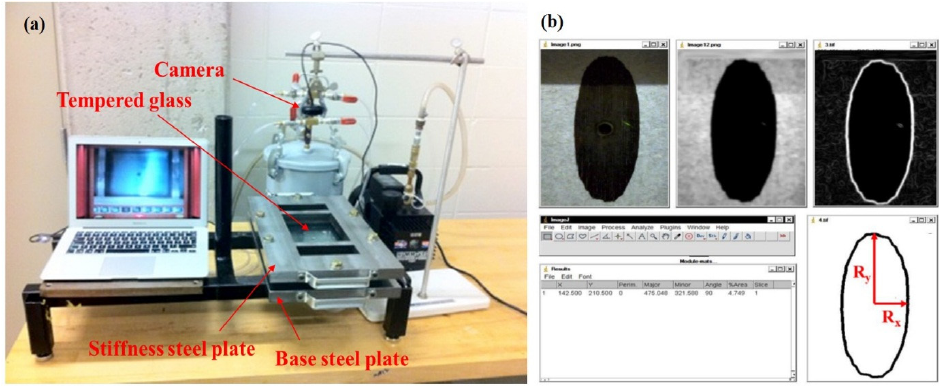
Figure 3. ( a ) Permeability measurement setup; ( b ) flow front shape and calculation of minor and major axis ( R x and R y ).